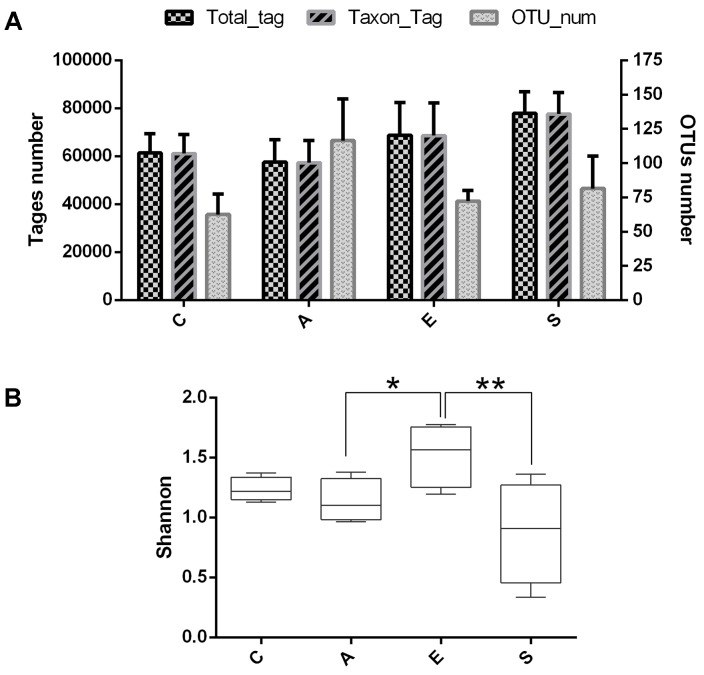
The OUT analysis of groups C, A, E, and S. (A) Number of total tags, taxon tags, and OTUs in groups C, A, E, and S. (B) The alpha-diversity distances calculated using phylotype relative abundance measurements among groups C, A, E, and S. C, PBS group; A, Fermentation product of S. marcescens KH-001 group; E, E. coli DH5α group; S, S. marcescens KH-001 group. ∗p < 0.05; ∗∗p < 0.01.